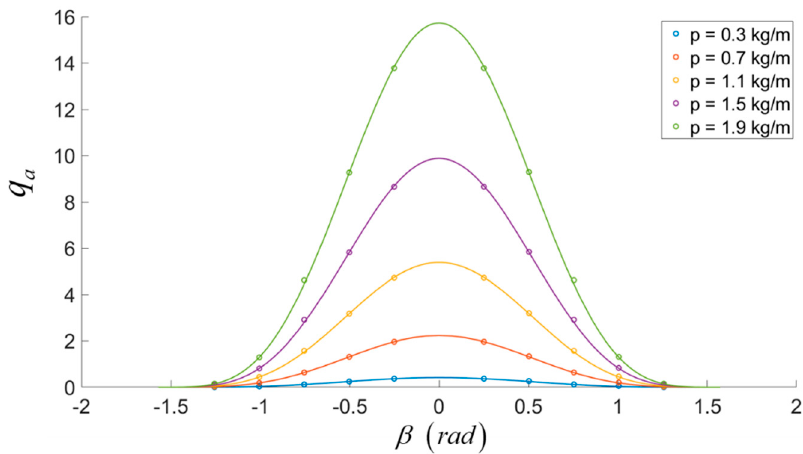
Figure 14. The relationship between β and q a with di ff erent ρ